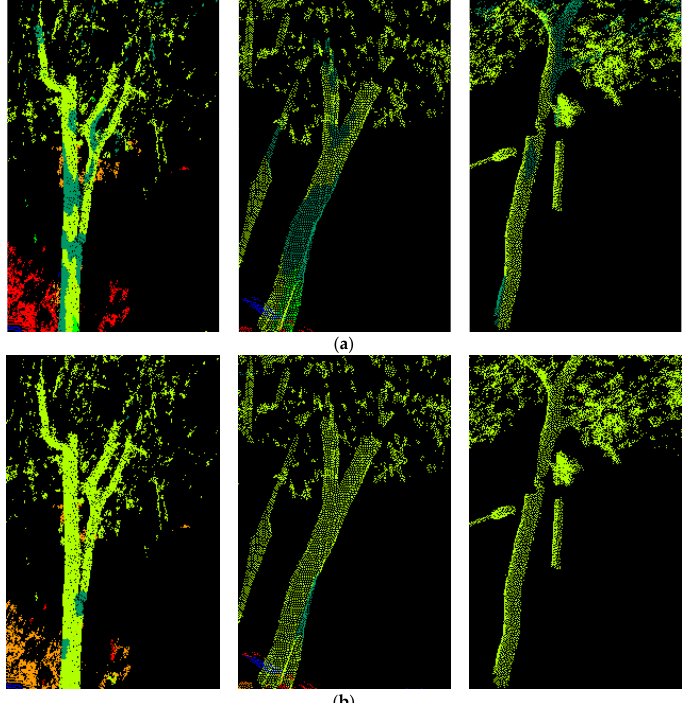
Figure 5. Examples of the misclassification between façades and trees with different feature sets: ( a ) Geo, ( b ) Geo & C.